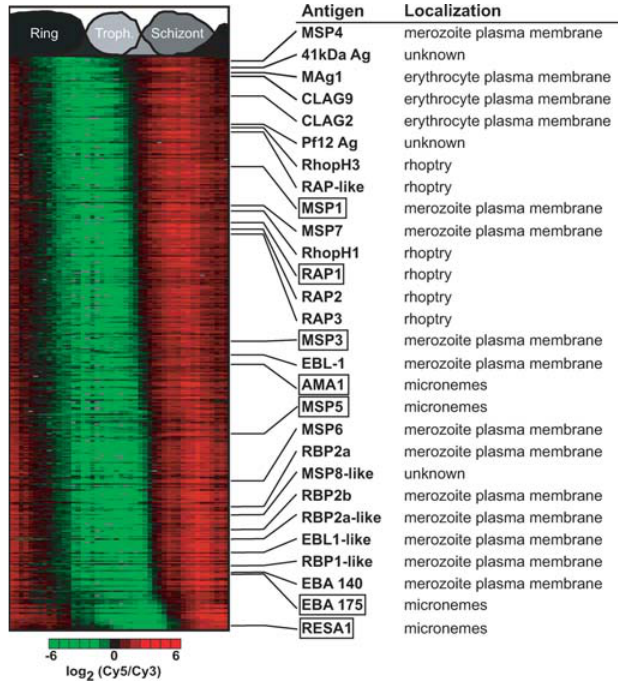
Figure 5. Phaseogram of Putative Vaccine Targets The similarity of all expression profiles to seven known vaccine candidates (boxed) was calculated. The top 5% of similar profiles correspond to 262 ORFs, 28 of which have been previously associated with plasmodial antigenicity and the process of merozoite